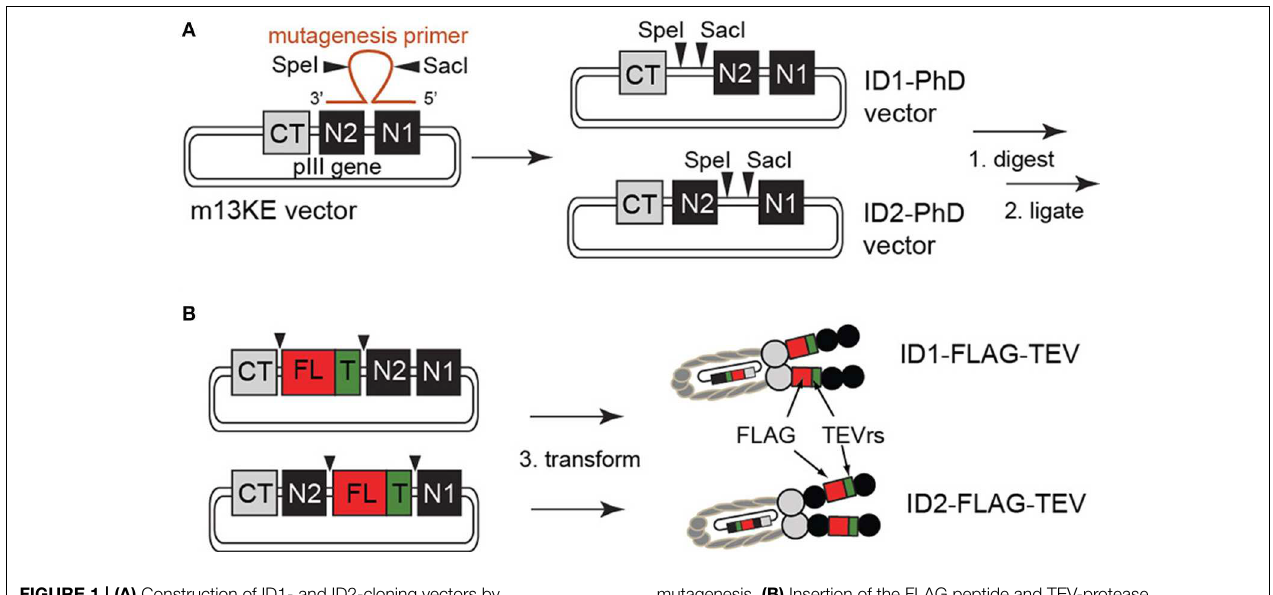
mutagenesis. (B) Insertion of the FLAG peptide and TEV-protease recognition site was achieved by restriction enzyme digest and subsequent ligation of a synthetic TEVrs-FLAG DNA fragment. All constructs were validated by sequencing (see Supplementary